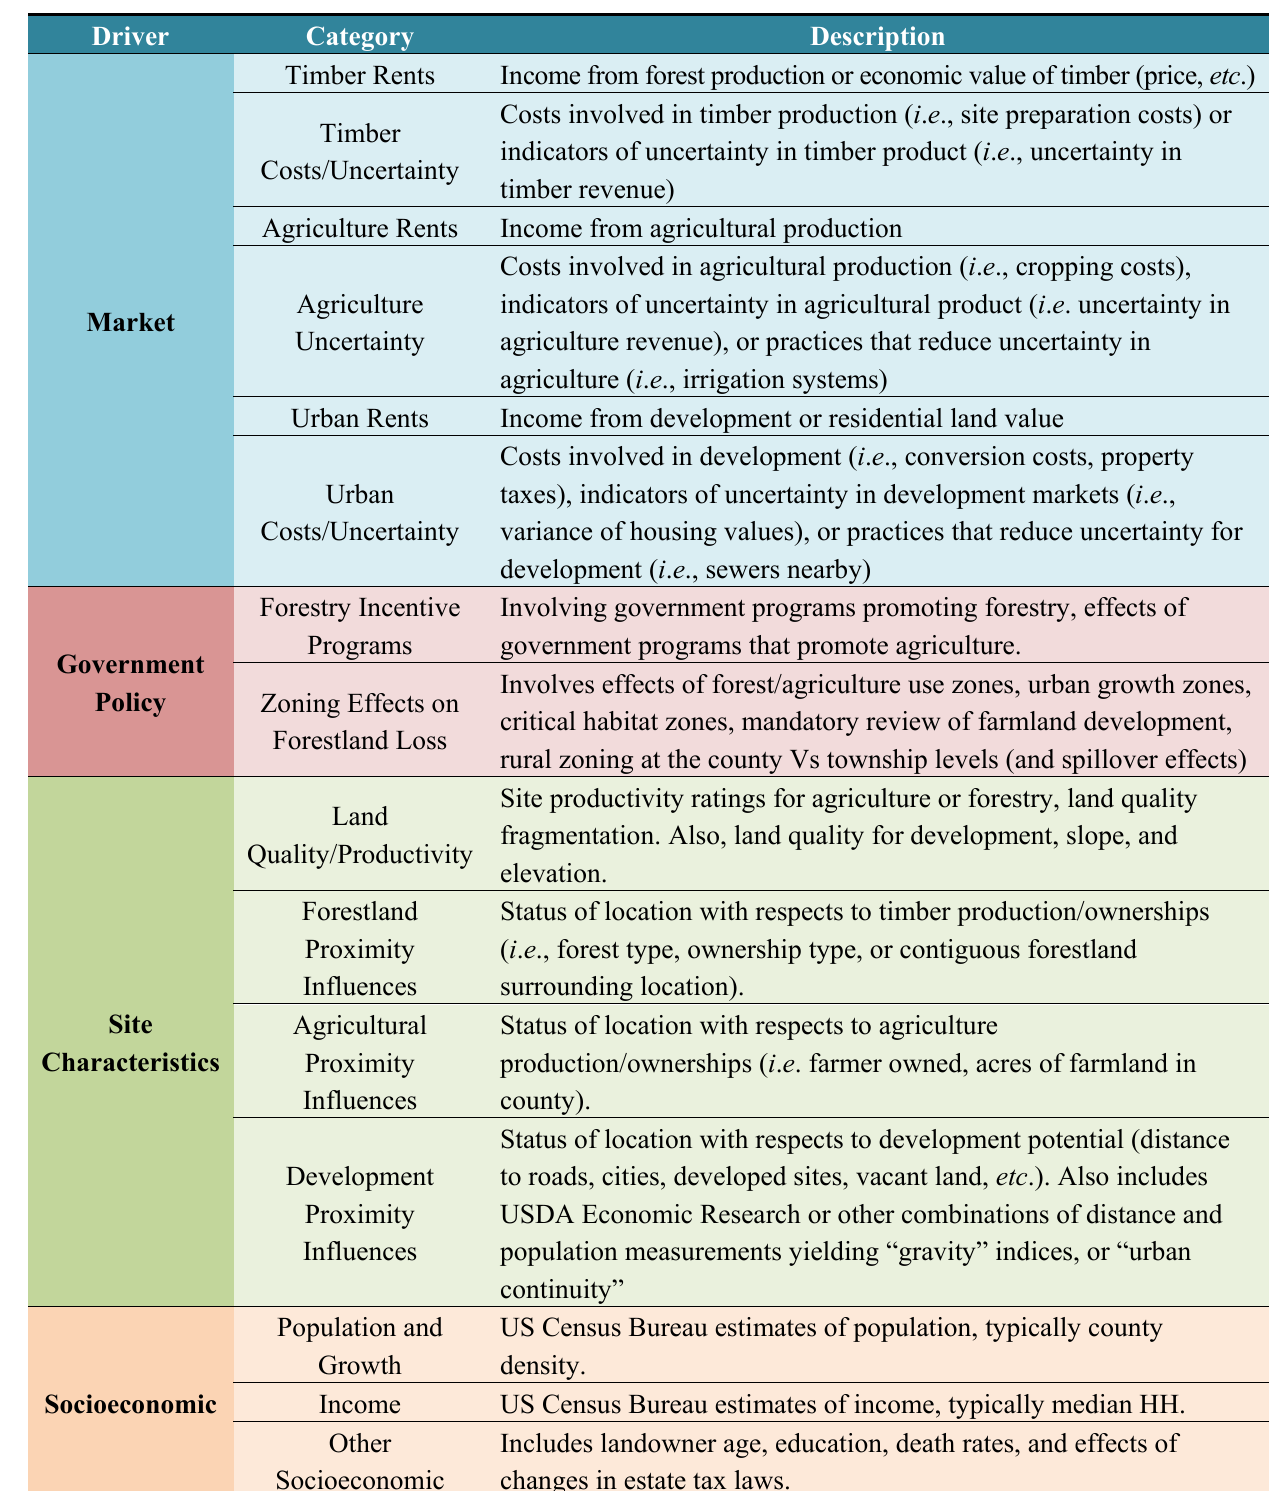
Table 3. Description of 15 categories used to organize variables from 64 econometric models for use in vote count